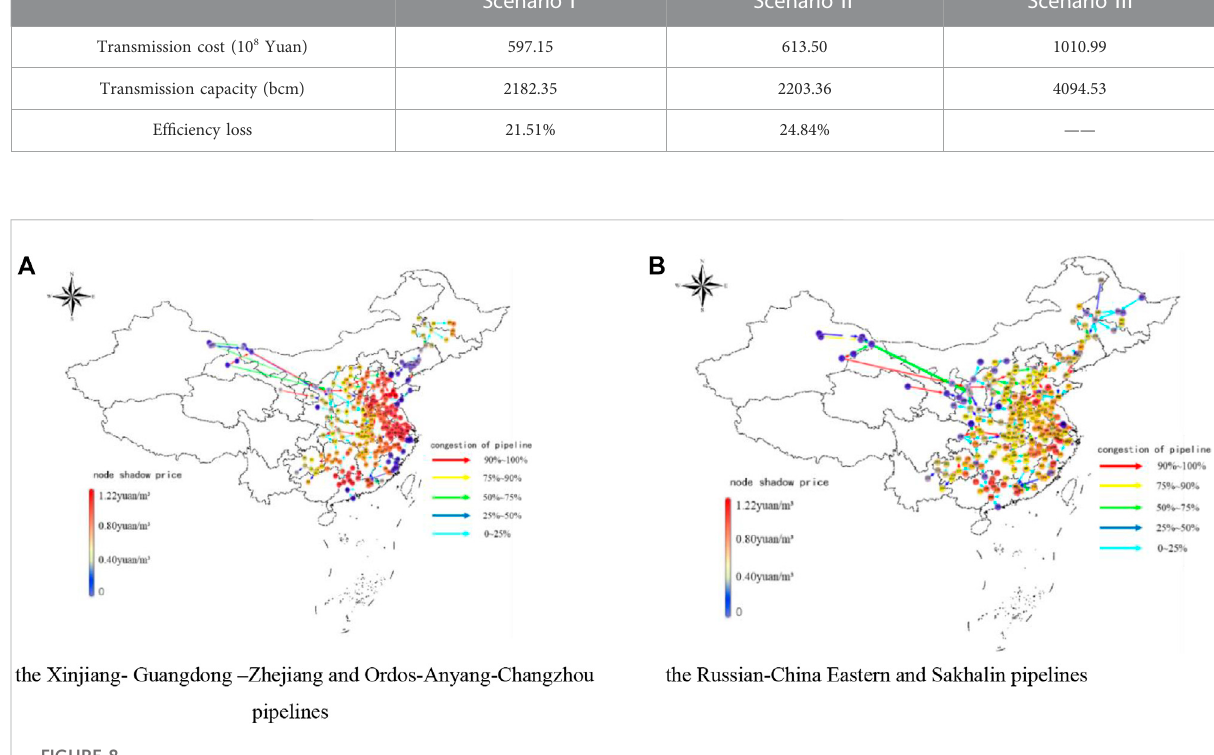
FIGURE 8 Distributions of nodal prices and pipeline congestions in scenario Ⅰ and Ⅱ (A) the Xinjiang- Guangdong – Zhejiang and Ordos-Anyang- Changzhou pipelines (B) the Russian-China Eastern and Sakhalin